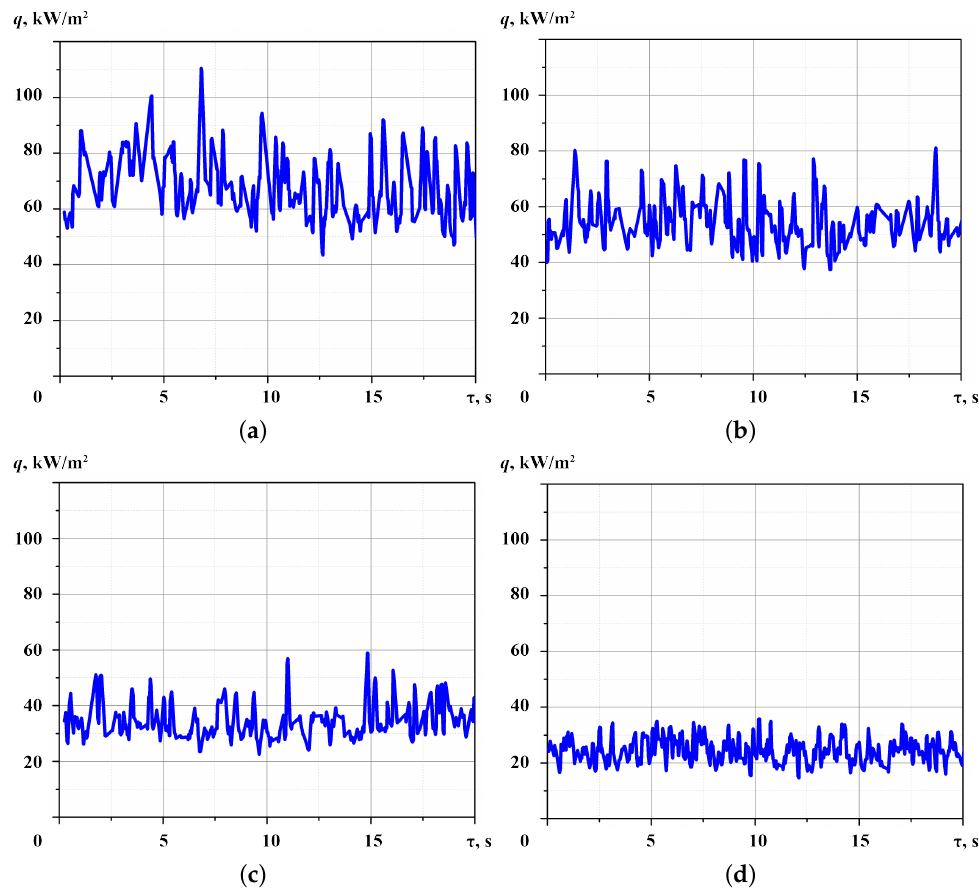
Figure 4. Time-dependent heat flux graph by GHFS for condensation of saturated steam on the upper generatrix of the pipe at the surface temperature: ( a )—322 K; ( b )—337 K; ( c )—354 K; ( d )—362